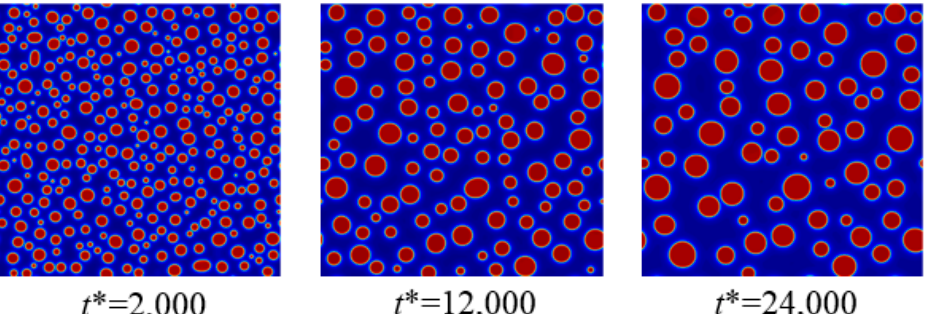
Figure 2. Simulation snapshots of the precipitate evolution in absence of nanoparticles at different times. The precipitates are colored red, and the matrix is in dark blue.